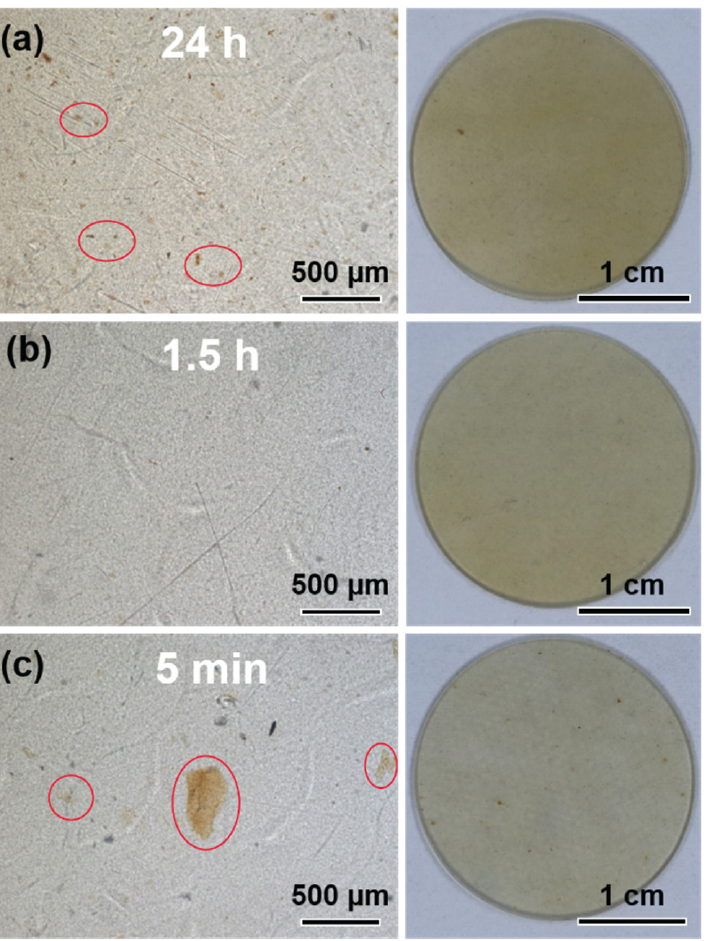
Figure 5. Optical microscopic and digital images of nylon/CSW nanocomposite ( a ) 24 h, ( b ) 1.5 h, and ( c ) 5 min.